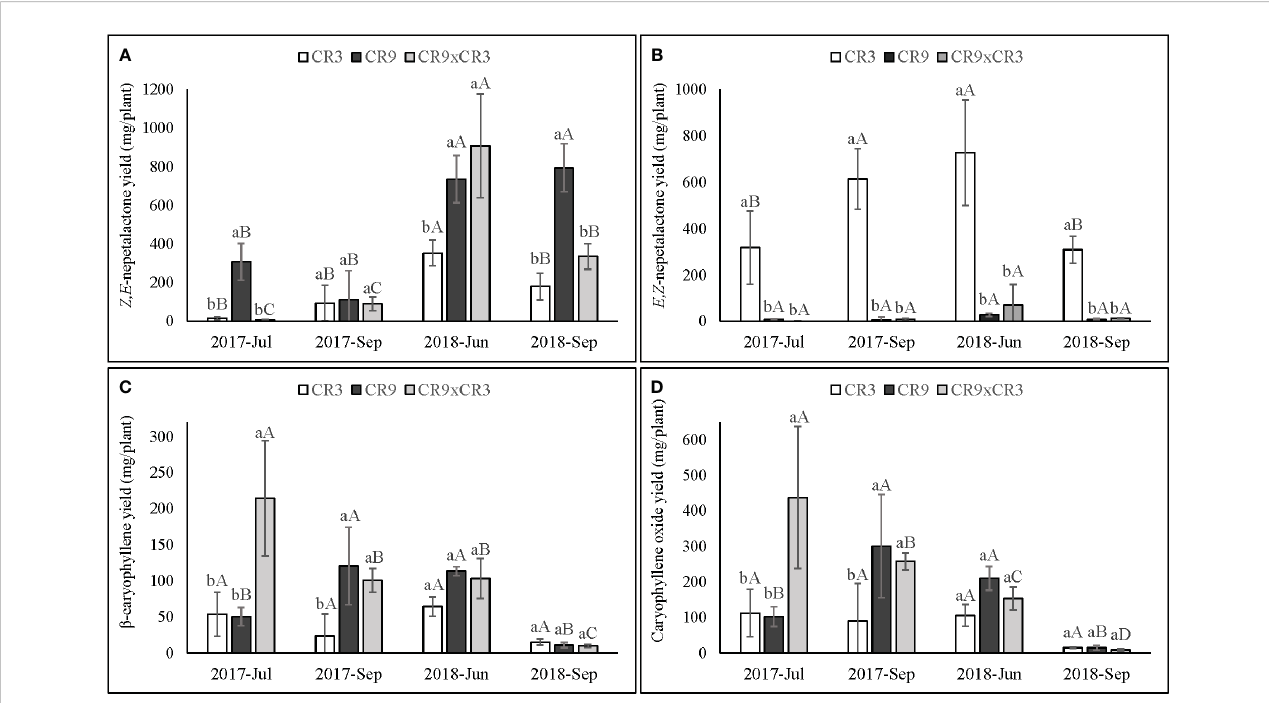
FIGURE 4 Yields (mg per plant) of Z,E -nepetalactone (A) , E,Z- nepetalactone (B) , b -caryophyllene (C) and Caryophyllene oxide (D) in catnip genotypes at different harvest times. Pittstown, NJ, United States. Vertical error bars indicate standard deviation. Uppercase letters indicate statistical comparisons of the same genotype across harvests and lowercase letters indicate comparisons among the three genotypes inside the same harvest. Averages with different letters are statistically different by the Scott-Knott test ( p = ≤ 0.01). Estimated as a function of relative percentage of the individual compounds in the essential oil and the essential oil